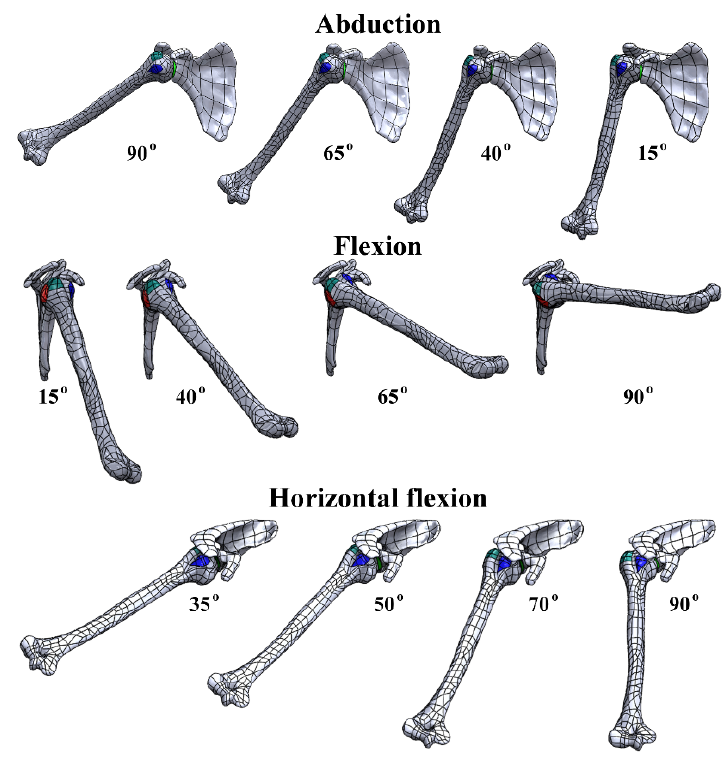
Figure 1. Definition of shoulder joint rehabilitation